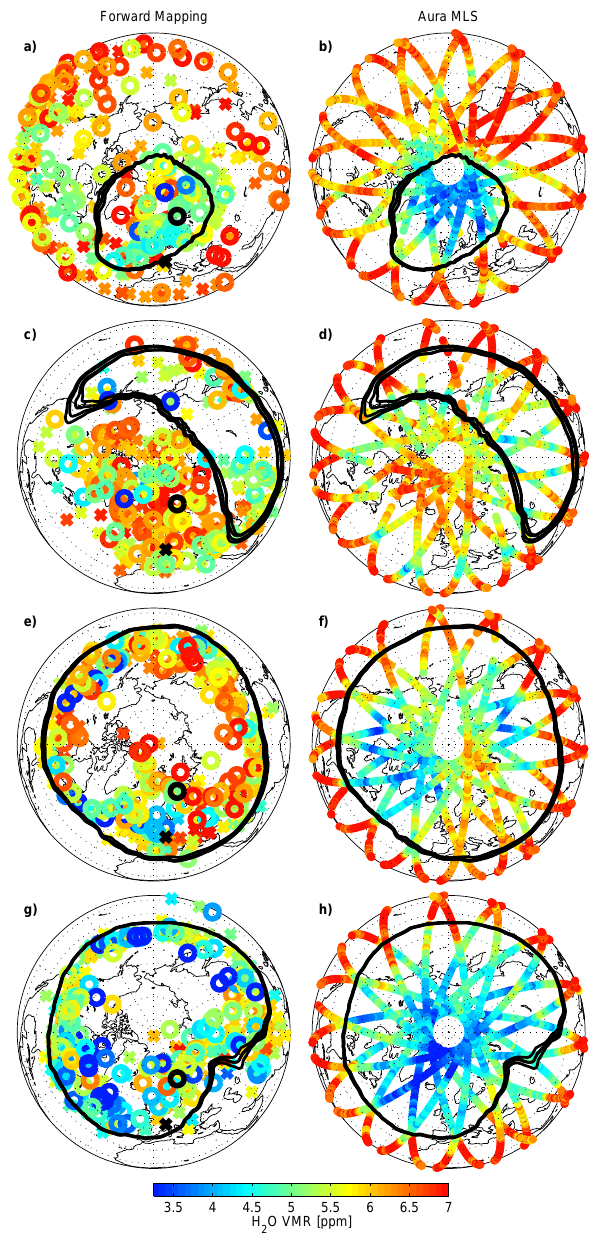
Fig. 7. H 2 O VMR within 0.14 and 0.07hPa (approximately 61 to 67km altitude). Left column: trajectory mapped ground-based H 2 O observations from Bern (crosses) and Sodankyla (circles). The black cross and circle indicate the location of MIAWARA (Bern) and MIAWARA-C (Sodankyl¨a), respectively. Right column: H 2 O measurements from Aura MLS v3.3, averaged between 0.14 and 0.07hPa. Red (blue) colors correspond to relatively high (low) H 2 O values. Units are ppm. The black contours indicate the edge of the polar vortex on four pressure levels within 0.14 and 0.07hPa. Dates are (from top to the bottom) 23 January (a, b) , 31 January (c, d) , 7 February (e, f) and 14 February 2010 (g, h)